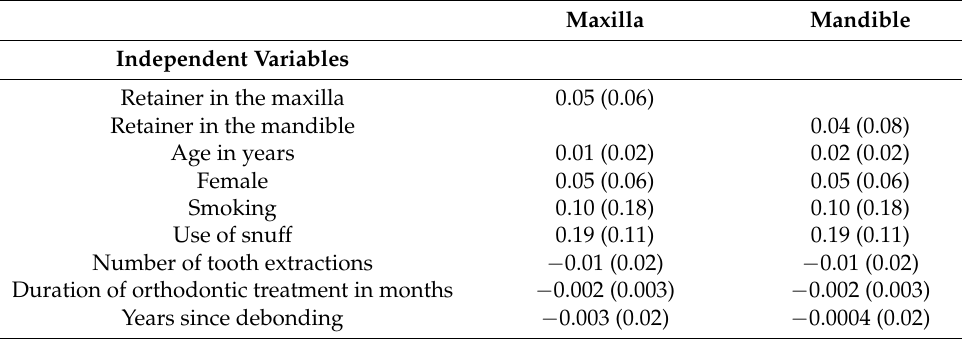
Table 3. Predictors of patient-reported oral hygiene performance.